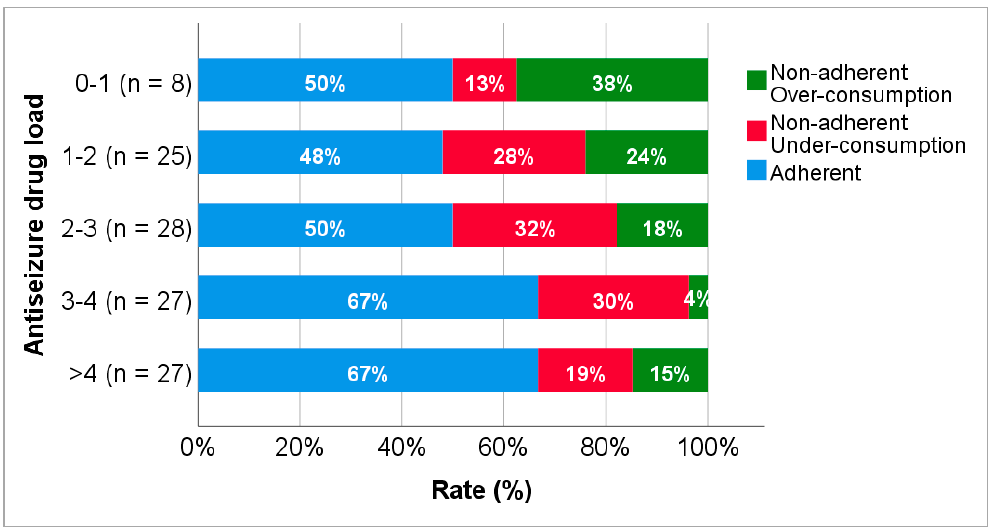
Figure 6. Adherence to levetiracetam according to the antiseizure drug load.